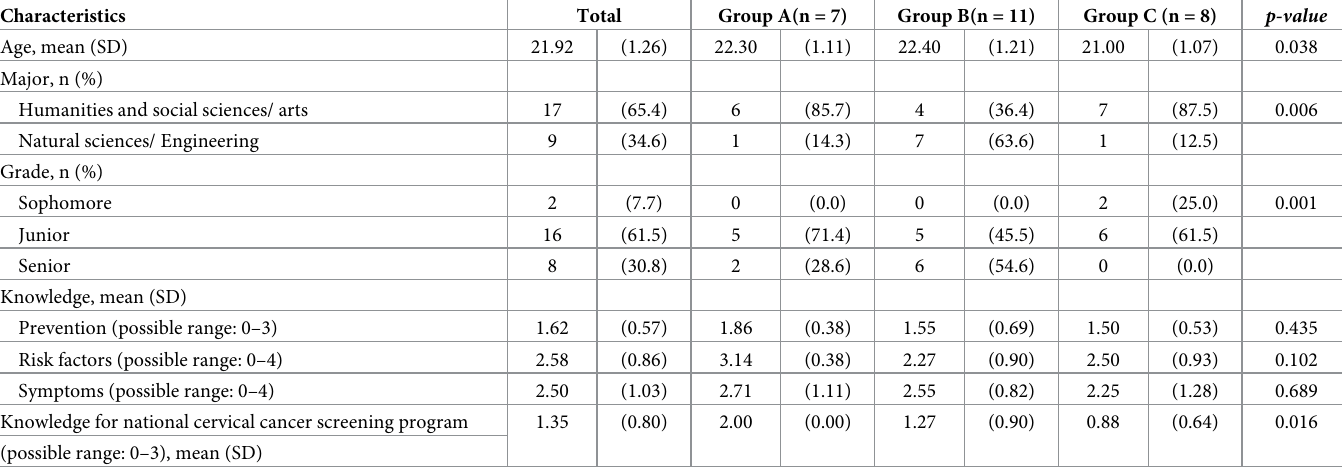
Table 1. Participants’ general characteristics (N =